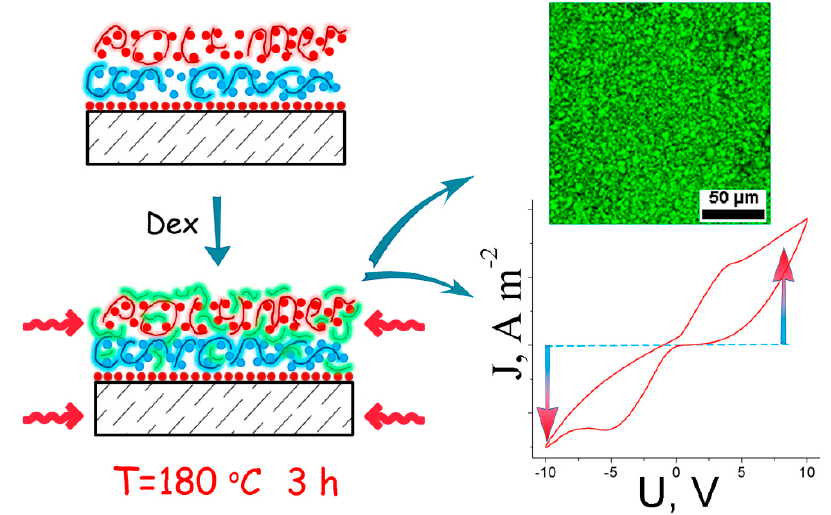
Figure 5. Scheme of layer-by-layer polymer film formation, and CLSM image and current-voltage characteristics of the 40 bilayers film (Adapted with permission from Reference [57]. Copyright (2019) John Wiley and Sons).